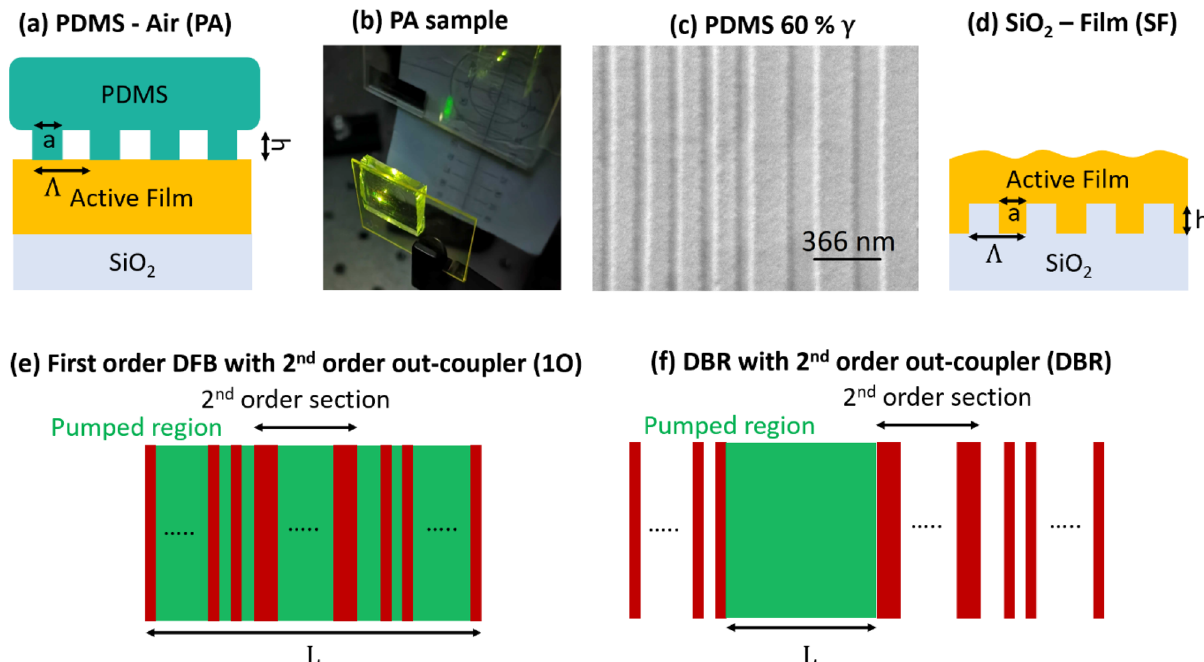
Figure 1. ( a ) Schematic for PDMS—air (PA) grating, ( b ) Pictogram of lasing from PA sample (pump beam filtered), ( c ) SEM of 60% γ 1st and 2nd order PDMS gratings, ( d ) schematic for substrate—film (SF) grating, ( e ) 1O DFB laser with 40 periods of a 2nd order grating out-coupler between 1st order gratings ( f ) 1O DBR laser with 1st order gratings and 40 periods of 2nd order grating out-coupler defined on a single mirror